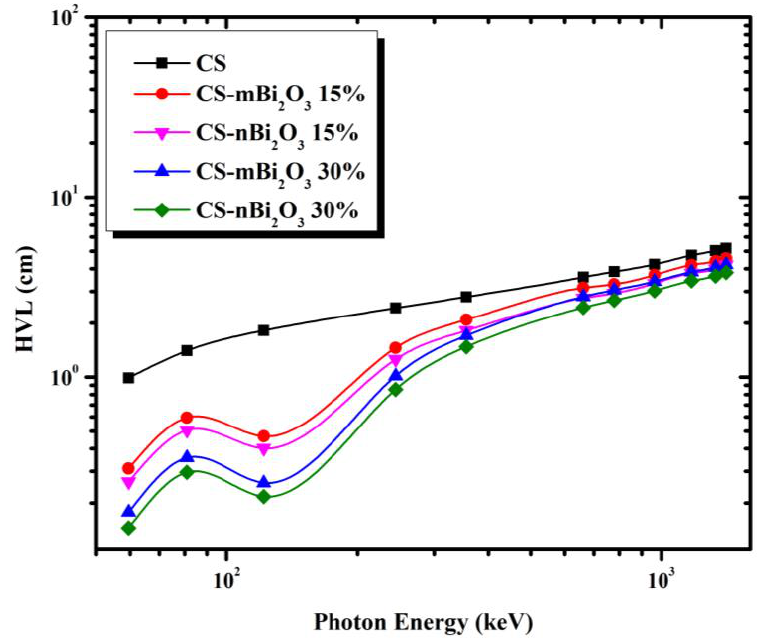
Figure 5. Half value layer (HVL) for the prepared mortars as a function of photon energy.